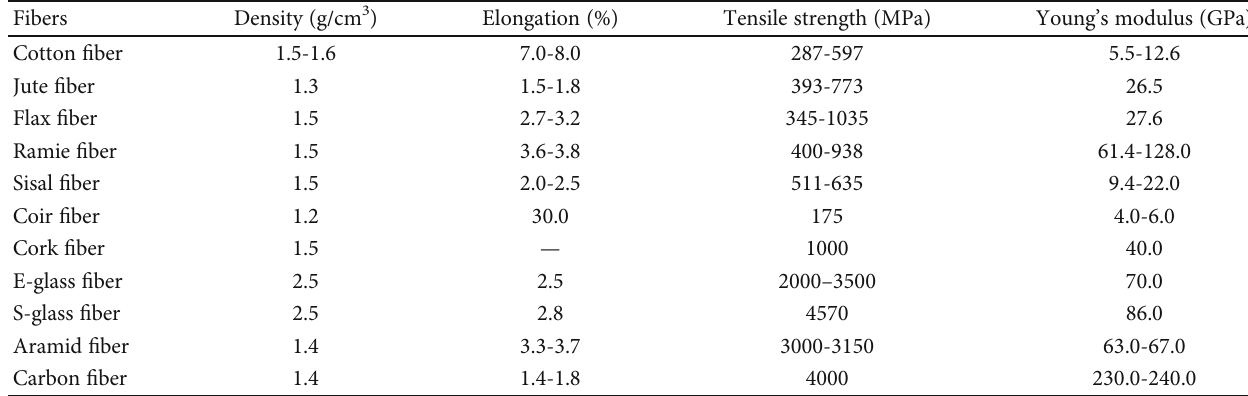
Table 1: Performance of CFs and commonly used fi bers.